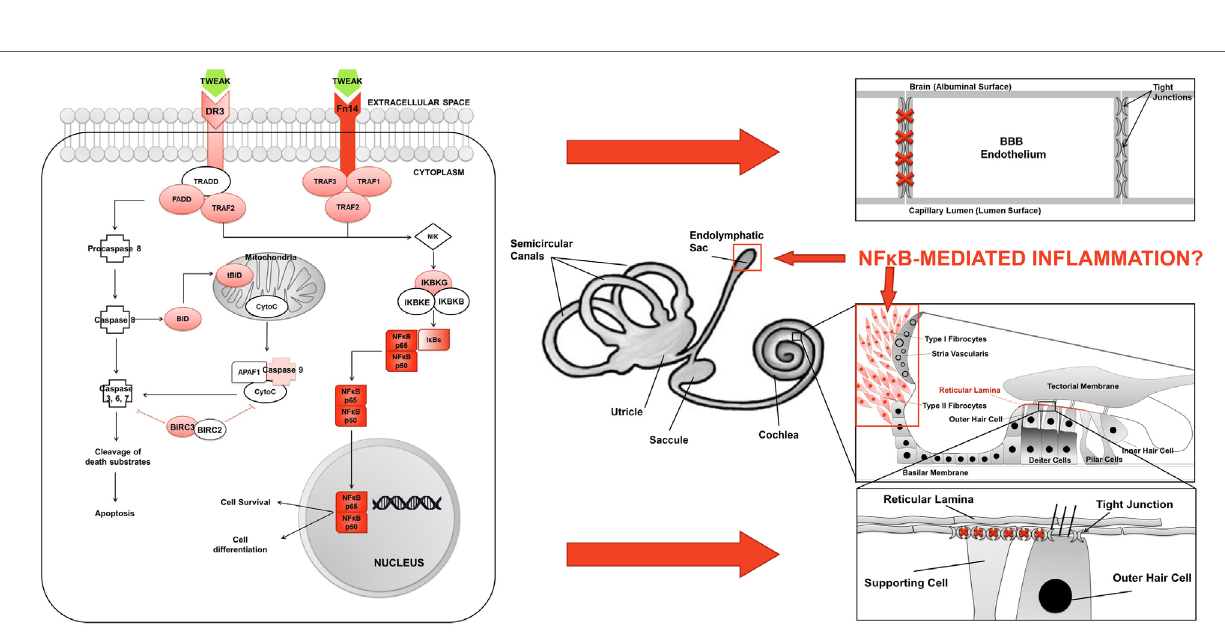
FigUre 6 | Inflammation model in Meniere’s disease (MD). (a) TWEAK/Fn14 pathway activates non-canonical NF- κ B signaling in lymphoid cells in MD. (B) Potential sites of inflammatory damage are the blood–brain barrier (BBB), the endolymphatic sac, the spiral ligament, and the reticular lamina in the neurosensory epithelium of the